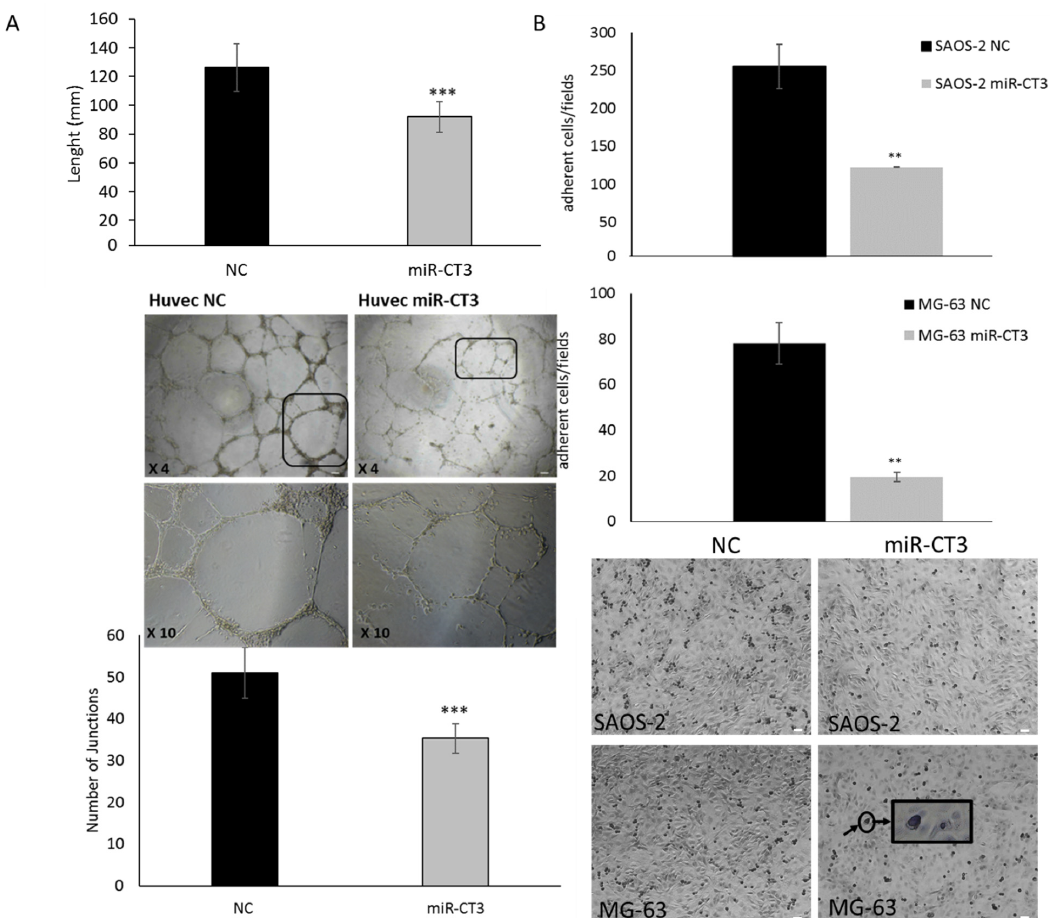
Figure 3. MiR-CT3 over-expression inhibits vessel formation and adhesion of OS cells on HUVEC cells. ( A ) Tube formation assay of HUVEC cells seeded on matrigel and treated for 24 h with the conditioned medium from SAOS-2 cells transfected with miR-CT3 mimics and NC. Barplots show the mean ± SD of the total length of tubes (top panel) and the number of junctions of tubes (bottom panel) per field quantified by counting 3 random fields/well under the microscope (4×) (*** p < 0.0005). In the middle a representative image of HUVEC cells treated as described above. ( B ) Adhesion assay of SAOS-2 and MG-63 cells transfected with miR-CT3 mimics and NC and seeded on to HUVEC cells monolayer (bottom representative image: the arrow indicates an OS cell (round and dark) adhered to the Huvec monolayer. Barplots show the mean ± SD of adherent cells per field by counting 3 random fields/well under the microscope (4×) (** p < 0.005).